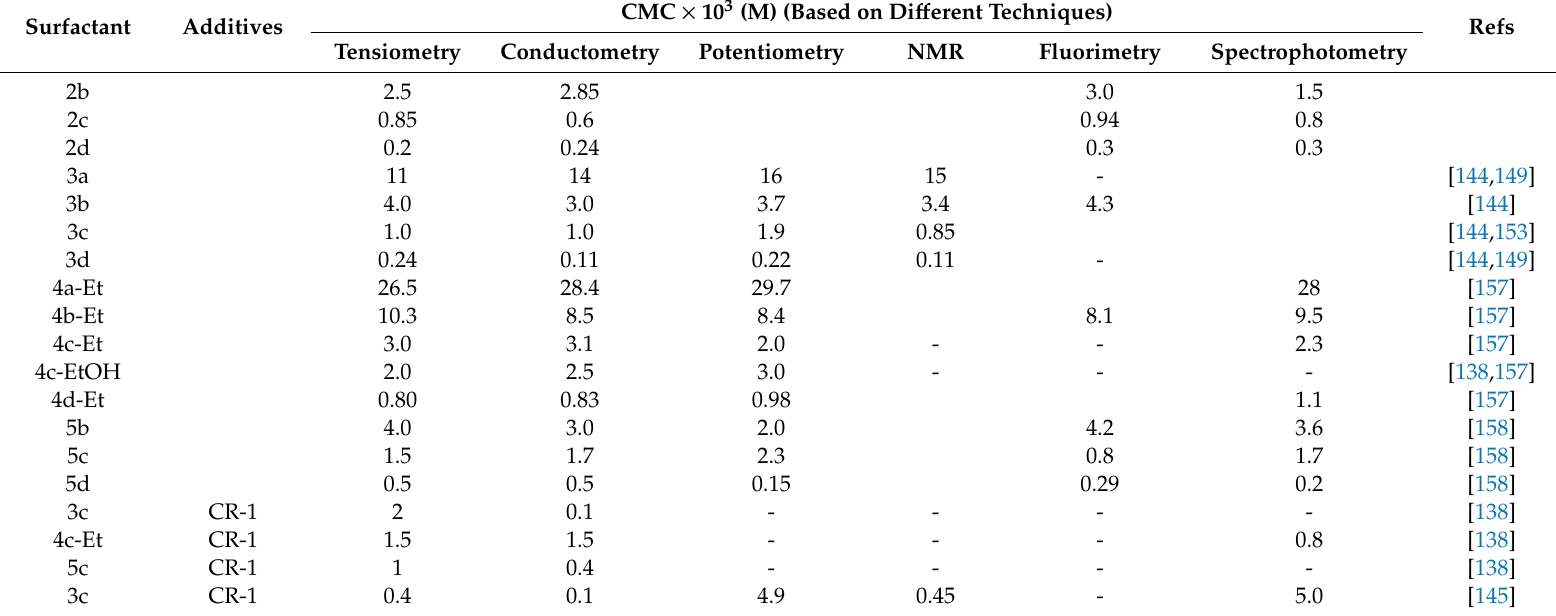
Table 2. Values of CMC of cationic surfactants in